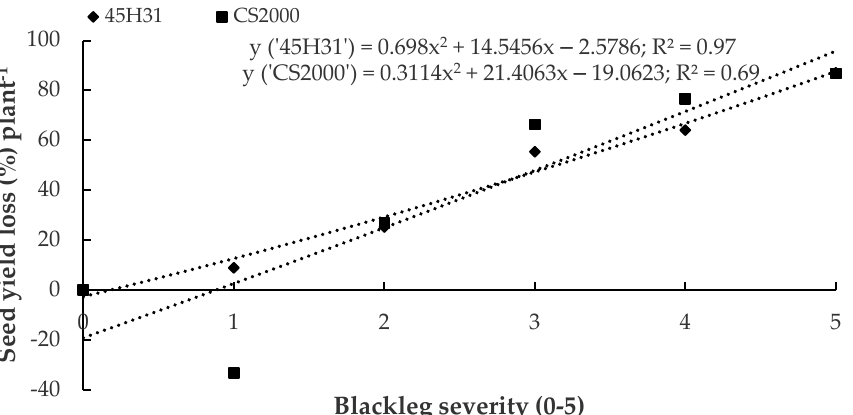
Figure 3. Relationship between blackleg severity and yield loss in the canola hybrids ‘45H31’ and ‘CS2000’ under field conditions. Data were collected over two years (2019 and 2020) at two sites in Edmonton, AB, Canada. The yield loss data were estimated using the y-intercept in the equation averaged over four site-years. The data points were transformed into the percentage of the maximum yield.